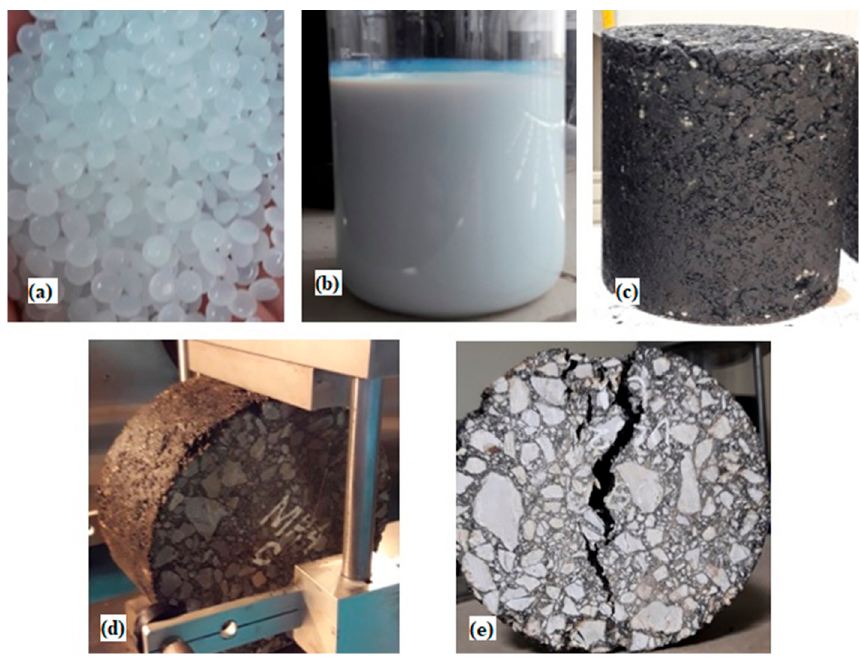
Figure 3 . Materials and testing: ( a ) HDPE pellets; ( b )SBR Latex; ( c ) prepared sample; ( d ) ITS test; and ( e ) specimen after test.